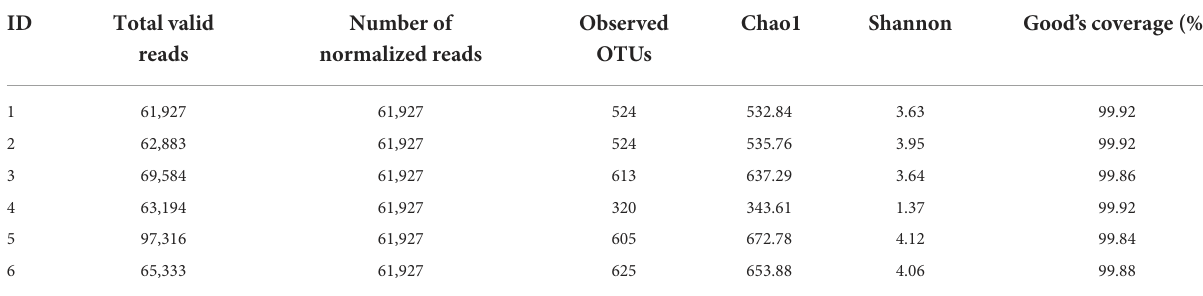
TABLE 2 Summary of the alpha diversity indices of the skin